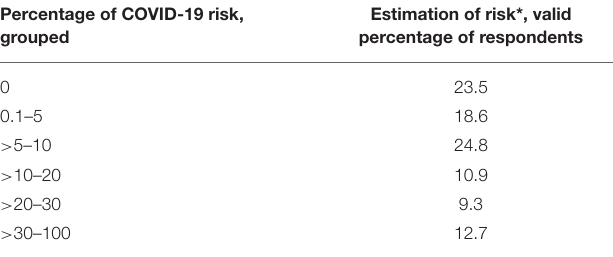
TABLE 2 | Estimated likelihood of COVID-19 infection. Percentage of COVID-19 risk, grouped